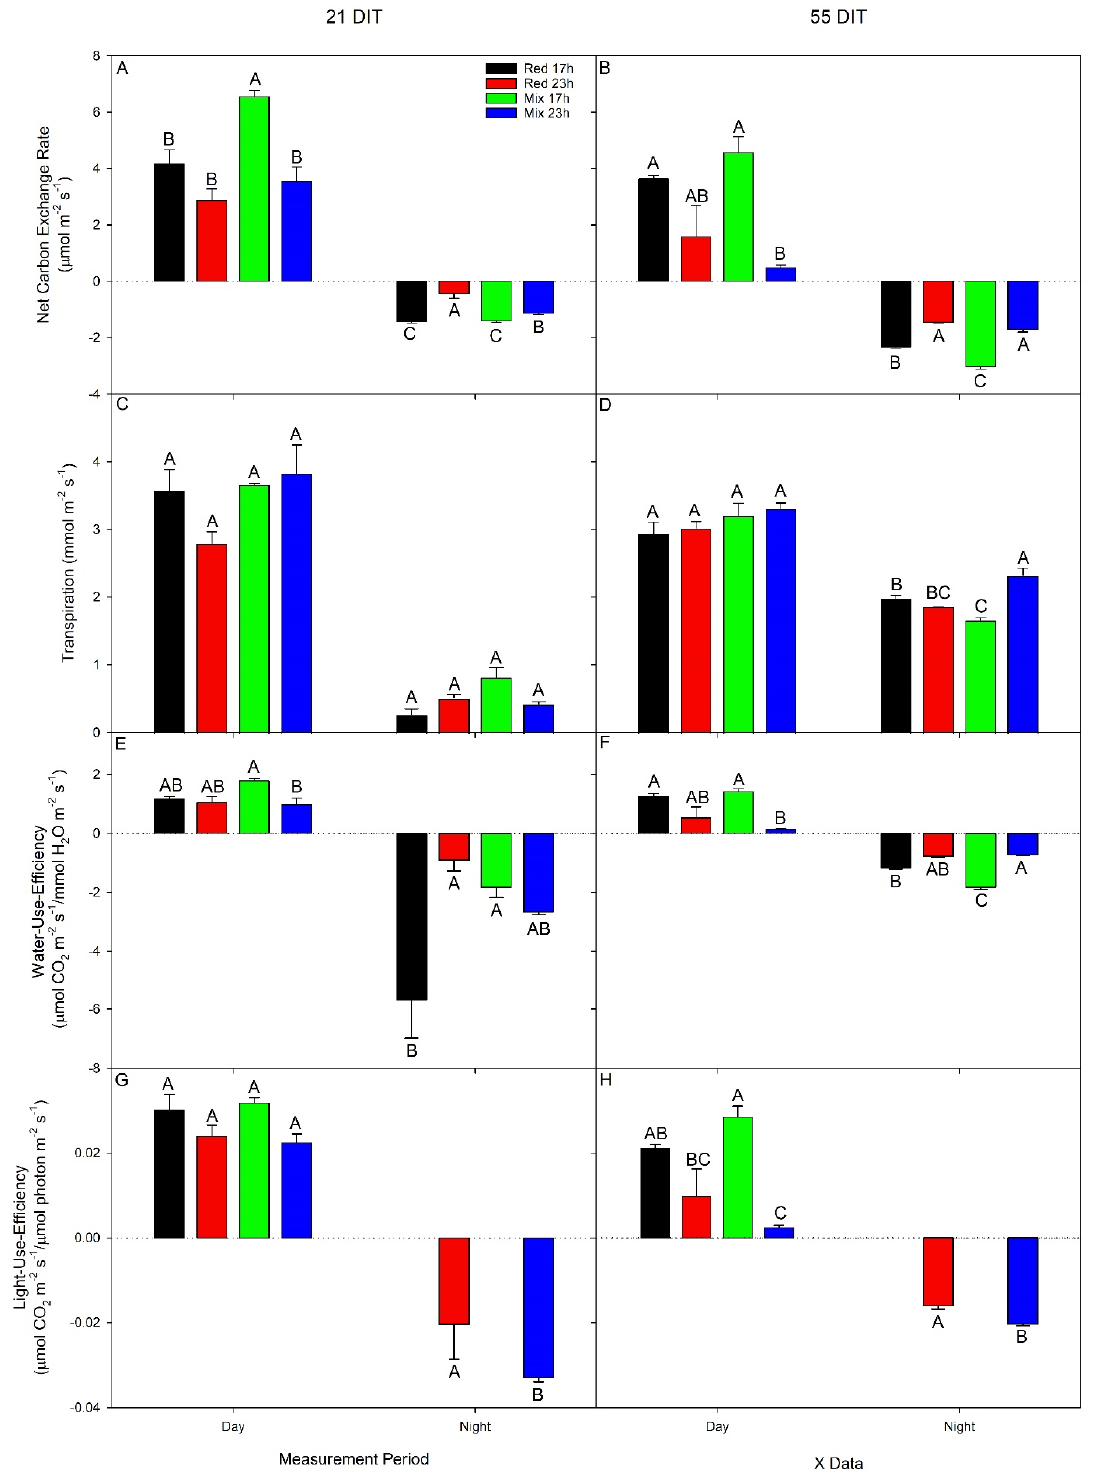
Figure 5. Net carbon exchange rate (NCER; panel A , B ), transpiration (panel C,D ), water use efficiency (panel E , F ), light use efficiency (panel G , H ) of the 5th leaf from TE tomato plants grown under either red 17 h, red 23 h, mix 17 h, or mix 23 h lighting treatments at 21 DIT (December 6, 2018, panels A , C , E , G ) or 55 DIT (January 9, 2019, panels B , D , F , H ) during the daytime and nighttime. Measurements were performed using a Li-COR 6400 fitted with a clear-top chamber on a cloudy day or night and thus represent the NCER driven mostly by the supplemental lighting. Error bars represent the standard error of the mean of n = 3. Letter groups (A, B, C) represent significant differences within a panel between the lighting treatments at a specific data collection period at p <